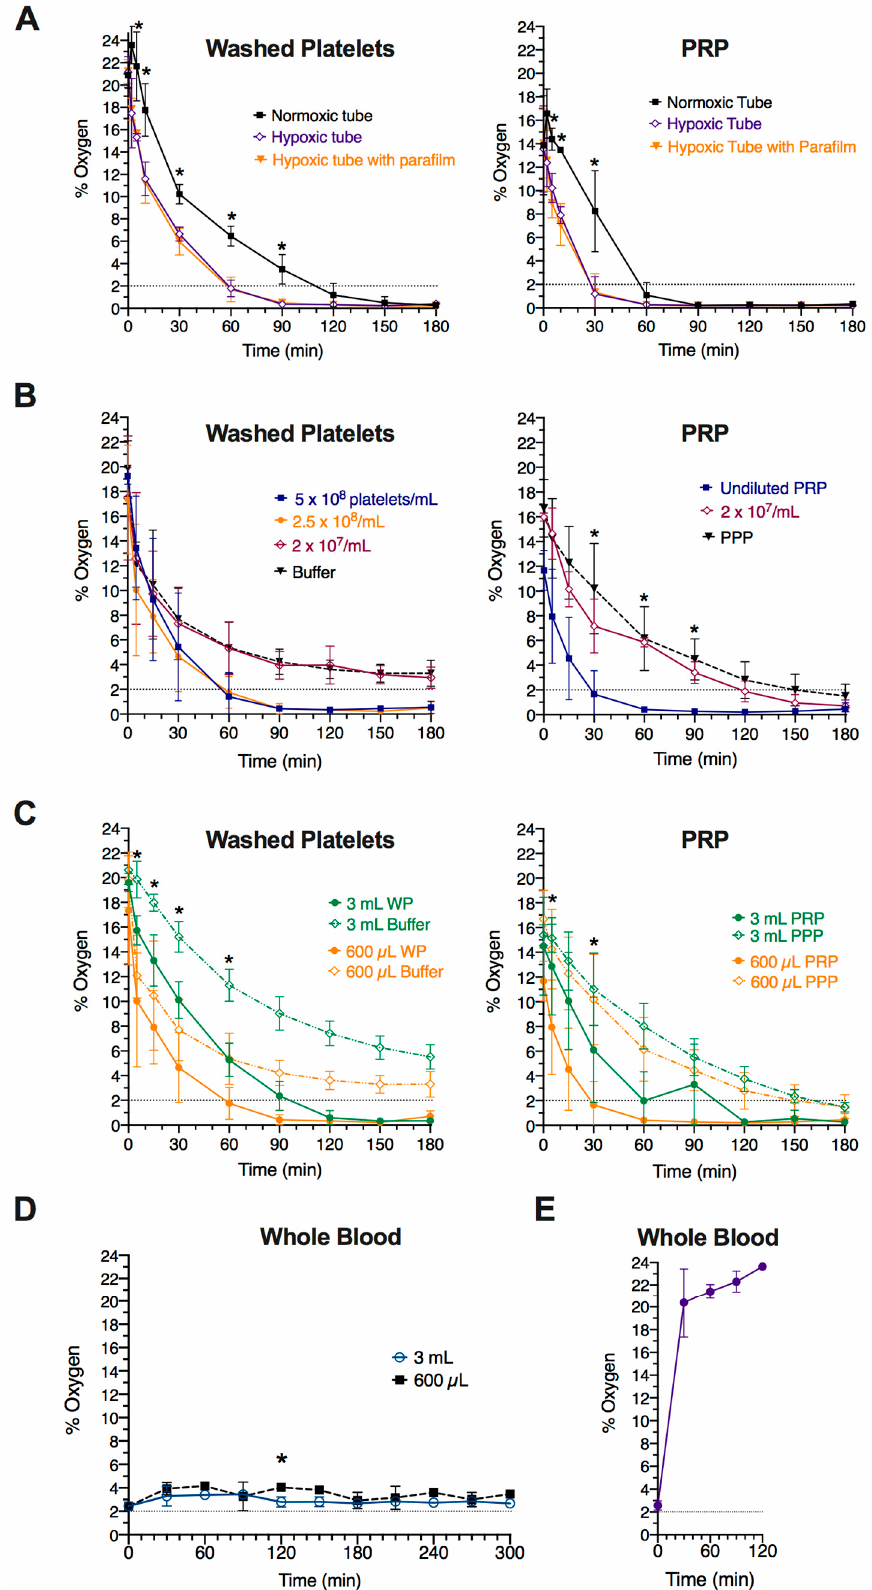
Figure 1. Effect of experimental conditions on oxygen level changes in platelet suspensions and whole blood incubated at 2% oxygen. Dissolved oxygen levels were measured using a fibre optic oxygen sensor in different samples as